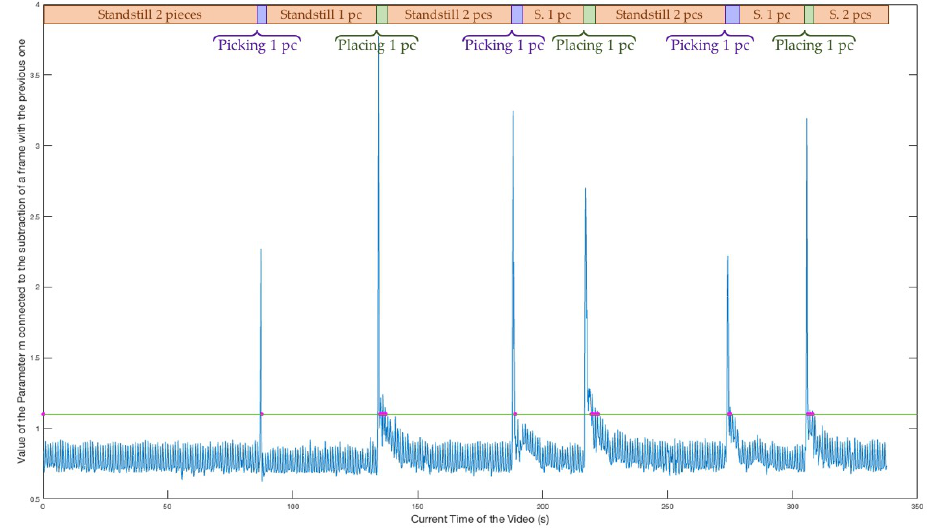
Figure 4. The parameter m at each instant of a sample